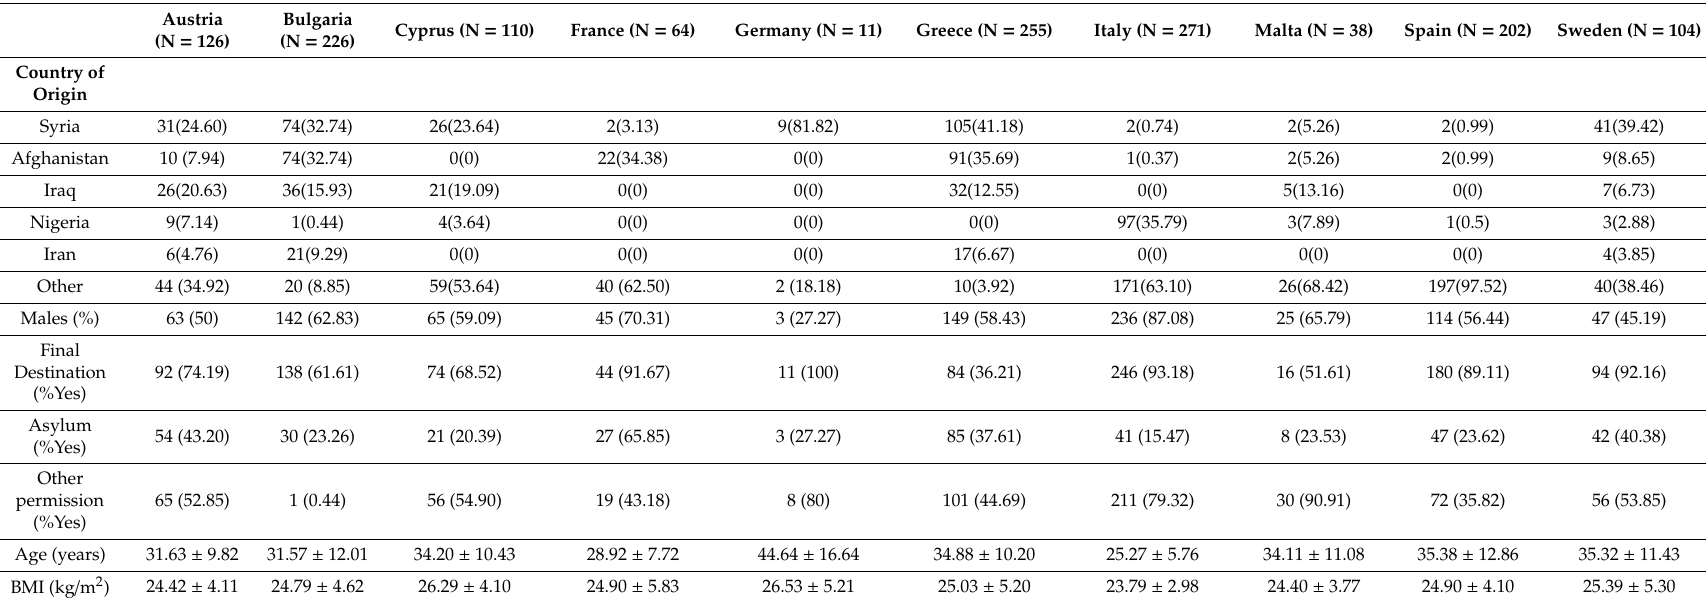
Table 2. Characteristics of migrants and refugees by country of